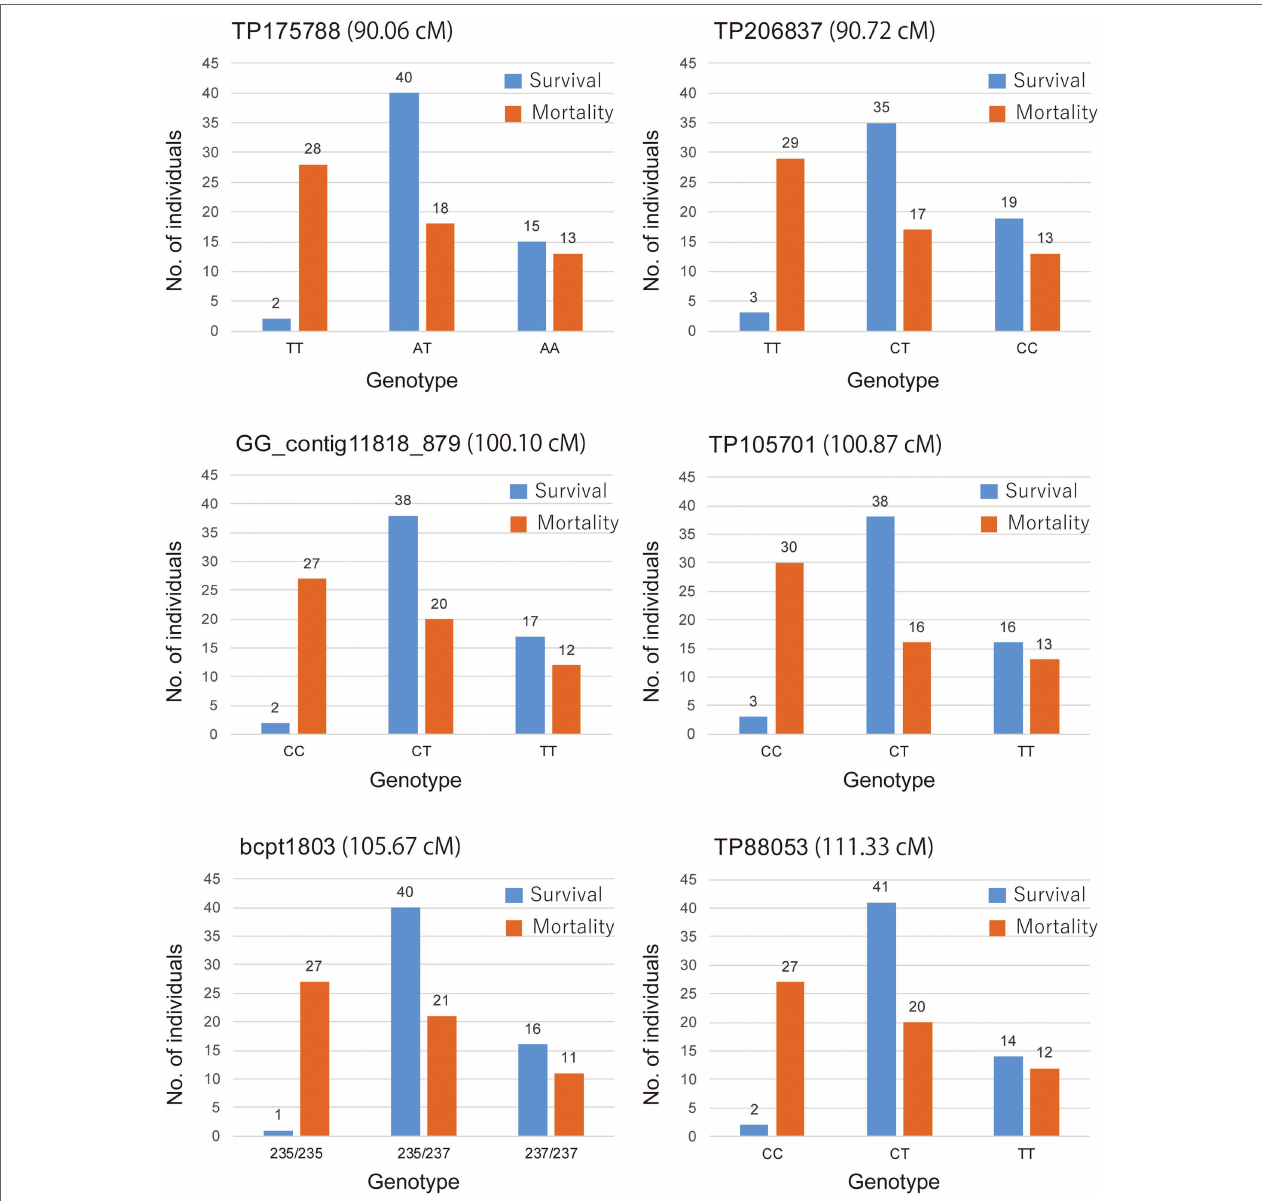
FIGURE 4 | Association between genotype and phenotype of PWD1 in the NK73 S 1 mapping population. Number of individuals in the survival and mortality categories for genotypes of marker on the QTL regions defined by a 1-LOD confidence